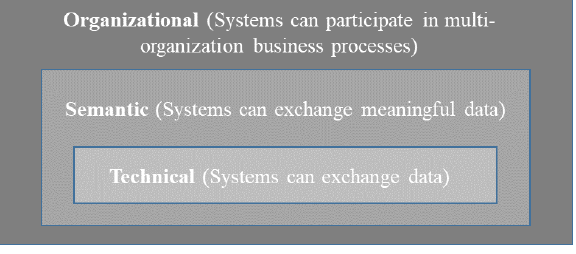
Figure 1. Interoperability Levels (Novakouski and Lewis, 2012) Semantic Interoperability: While technical